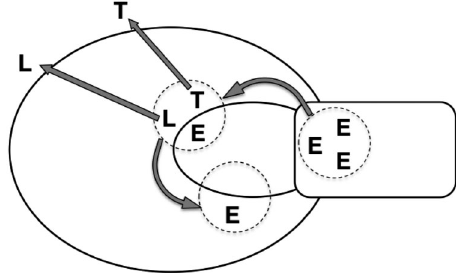
FIG. 2. ‘‘Electron’’ model of energy dynamics for an incan- descent bulb burning steadily. E, T, and L represent electrical, thermal, and light energy, respectively. The dashed circle denotes an